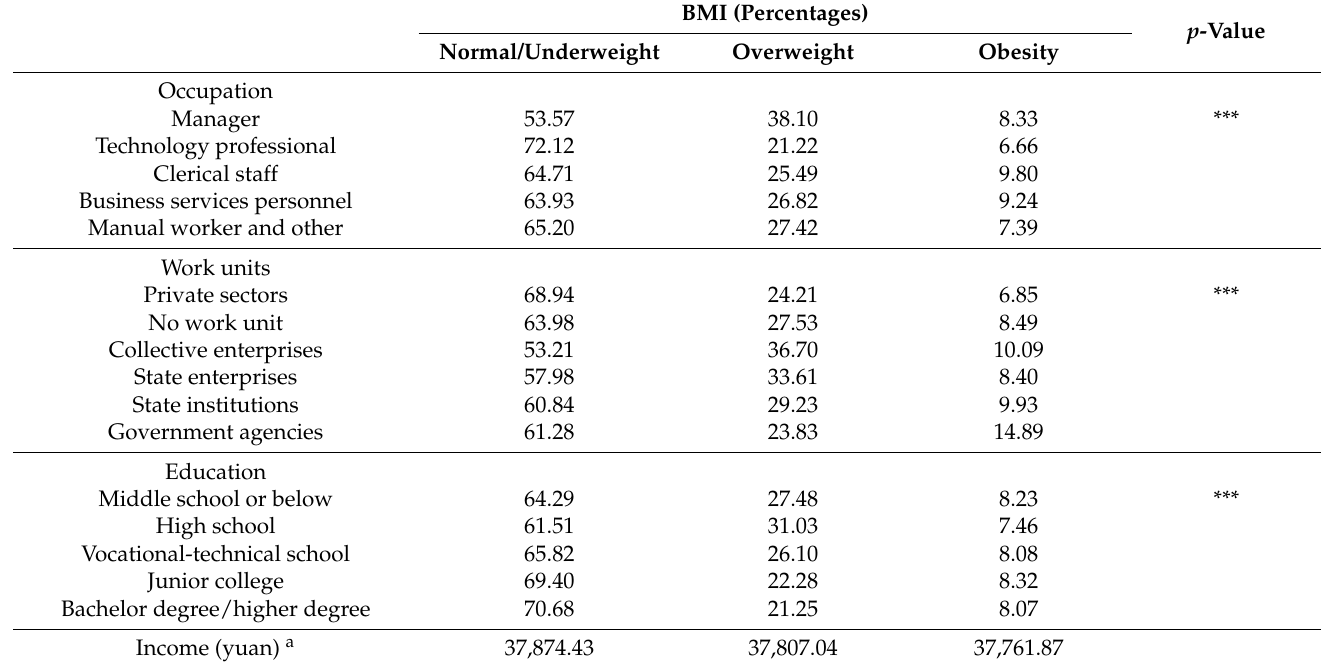
Table 2. Difference in BMI by main independent variable (100%).